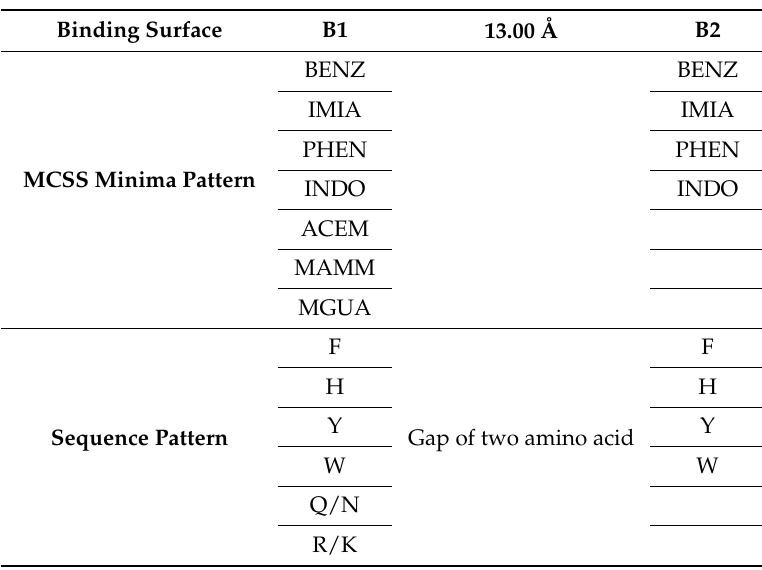
Table 6. Distribution of key minima and the derived sequence pattern for the binding epitope peptides to the antibody 4F5. A sequence pattern of “X-J”(X = R/K,Q/N,W,F/Y/H, and J = F/Y/H, W) was